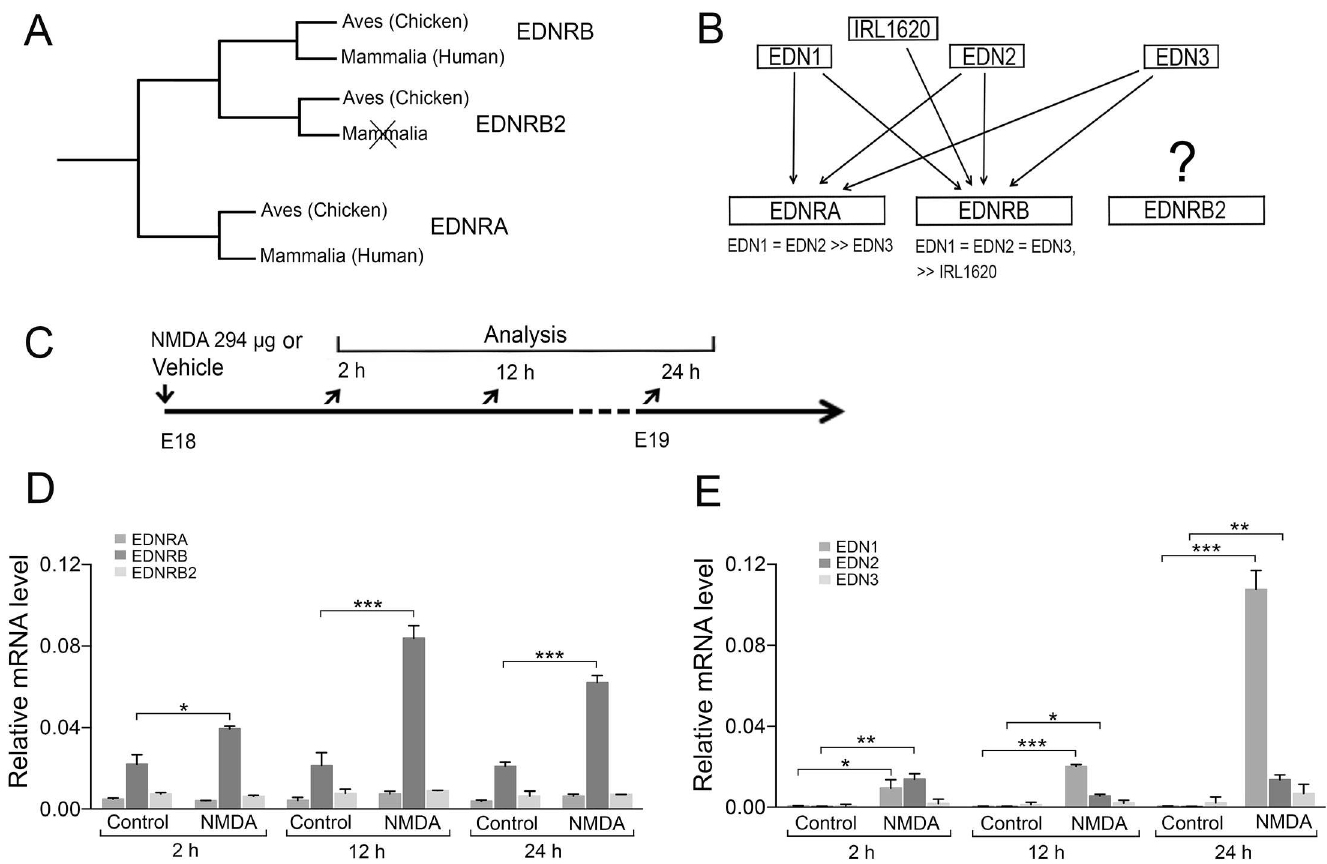
Fig 1. Endothelins and their receptors in retina after excitotoxic injury. (A) Schematic tree depictingorthologsand paralogsof the endothelin receptors (EDNRs) in Aves and Mammalia. EDNR2Bhas only beenfound in non-mammalian species. The tree is basedon Ensembl Gene tree ID: ENSGT00760000119177. (B) Interactions betweenthe endothelins (EDNs), the EDNRB agonistIRL1620and the EDNRs. (C) Experimental outline. QRT-PCR analysisof (D) EDNRA, EDNRB, EDNRB2and (E) EDN1, EDN2 and EDN3 mRNA levels in NMDA- or vehicle-(Control) treated eyes. Bar graphsshow the relative mRNA levels normalized to ß-actin. Bar graphs are mean ± SEM, n = 6 (control 2 h), n = 5 (NMDA 2 h), n = 6 (control 12 h), n = 5 (NMDA 12 h), n = 6 (control 24 h), n = 6 (NMDA 24 h, ( * P < 0.01, ** P < 0.001, *** P < 0.0001) analyzedby one-way ANOVA and Tukey’s post hoc test. Significance is only indicatedfor the comparisons: control-NMDA at 2h, 12h and